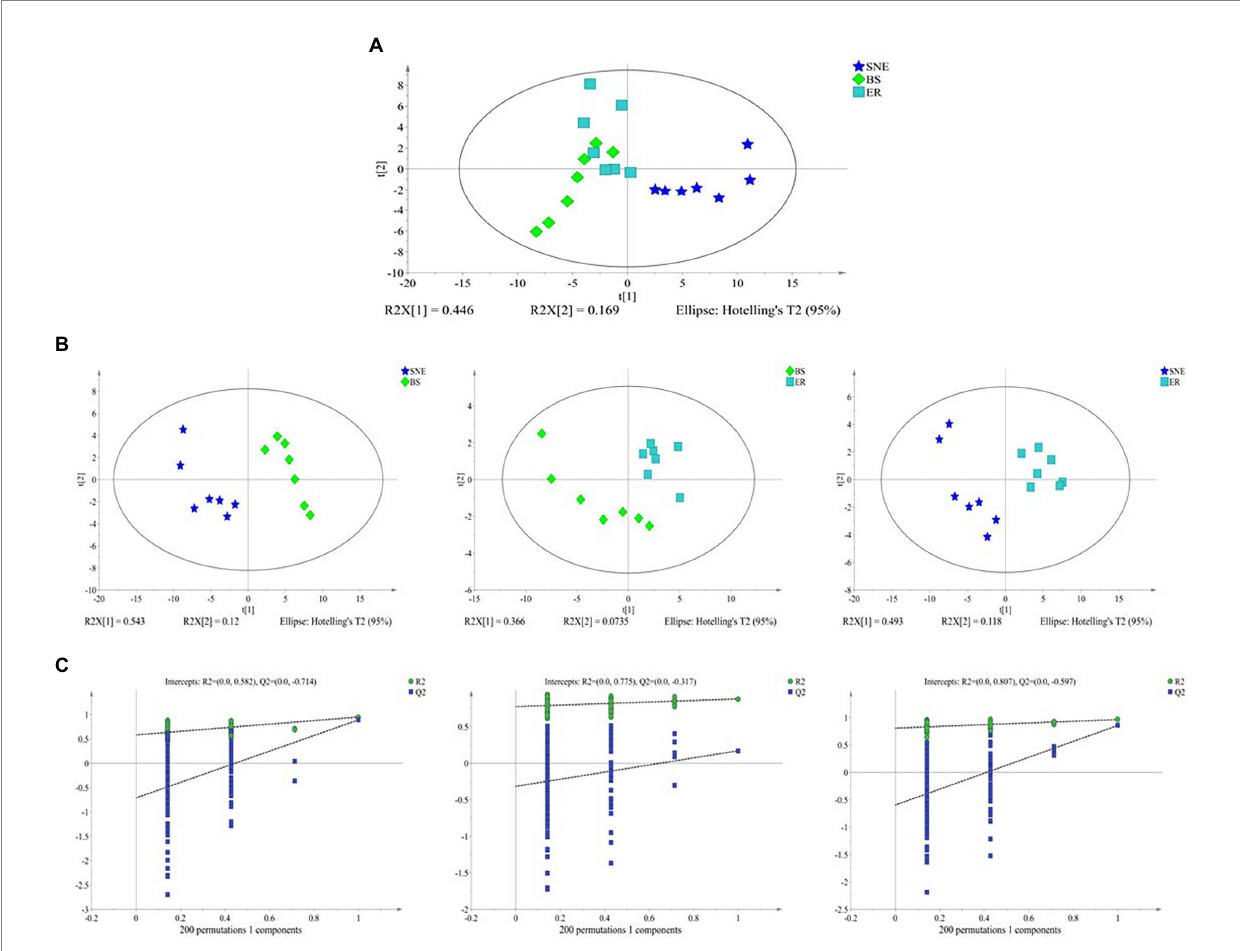
FIGURE 8 (A) Principal component analysis (PCA) score plots. (B) Projections to latent structure-discriminant analysis (PLS-DA) score plots of metabolic profiles obtained by BS vs. SNE [R2X = 0.663, R2Y = 0.949, Q2 = 0.894], ER vs. BS [R2X = 0.44, R2Y = 0.88, Q2 = 0.22] and ER vs. SNE [R2X = 0.795, R2Y = 0.991, Q2 = 0.898]; (C) permutation test of PLS-DA obtained by BS vs. SNE [left], ER vs. BS [middle] and ER vs. SNE [right]. SEM, standard error of mean. Each value represents the mean ± SEM of 7 replicates ( n = 7). The abbreviation of Ctr, SNE, BS and ER have the same meaning as Table